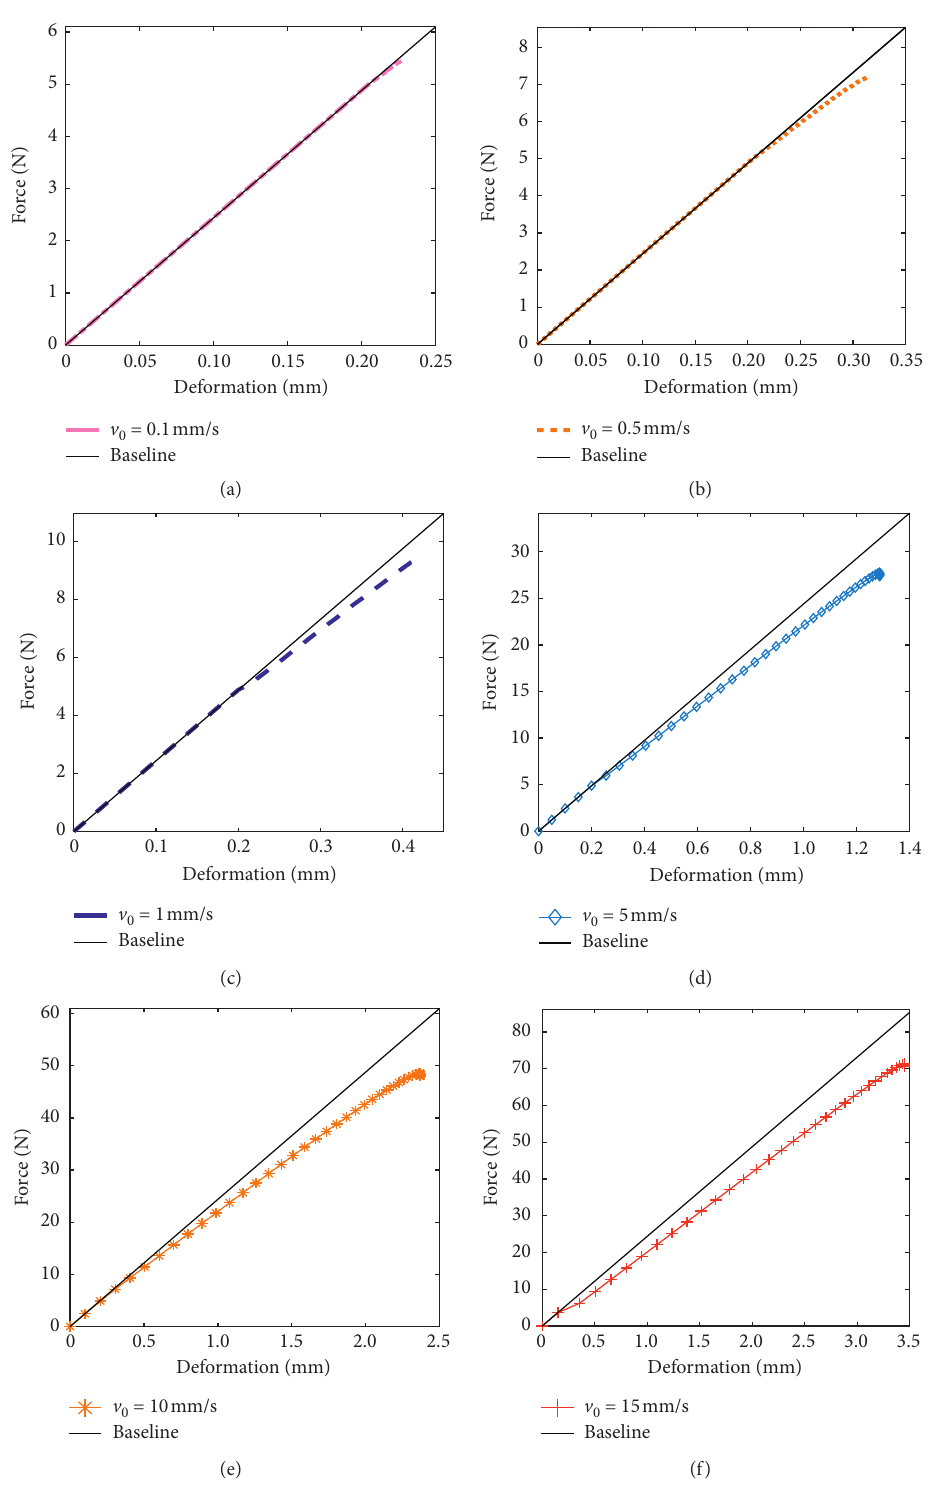
Figure 3: Curves of contact force with fruit deformation at different grasping velocities. (a) v v � 1mm · s − 1 . (d) v 0